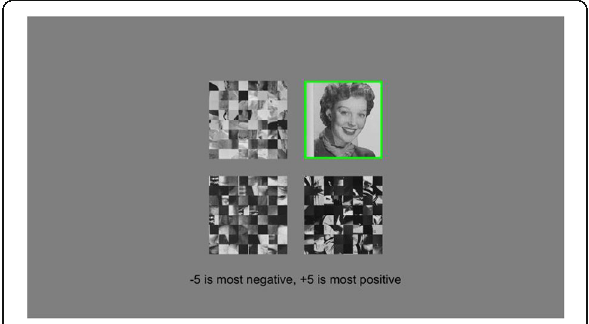
Fig. 4 Example trial from Part II. Participants saw four scrambled images, one of which was unscrambled and cued after 1